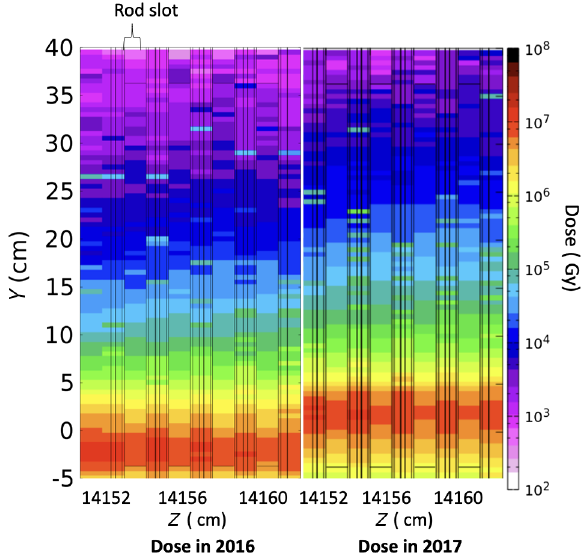
FIG. 3. Dose distribution in the BRAN prototype for the 2016 (left) and 2017 (right) p þ p runs, normalized to an integrated luminosity of 38.5 and 50 fb − 1 , respectively. The horizontal axis gives the distance from IP1, namely the Z -coordinate along the ATLAS detector axis. The vertical axis gives the distance from the beam height, namely the Y -coordinate along the axis opposite to gravity. Dose values are averaged over a 9-mm interval in the missing third dimension, corresponding to the horizontal orthogonal x axis pointing outside the LHC ring. The vertical shift in the maximum exposure position is due to the crossing angle